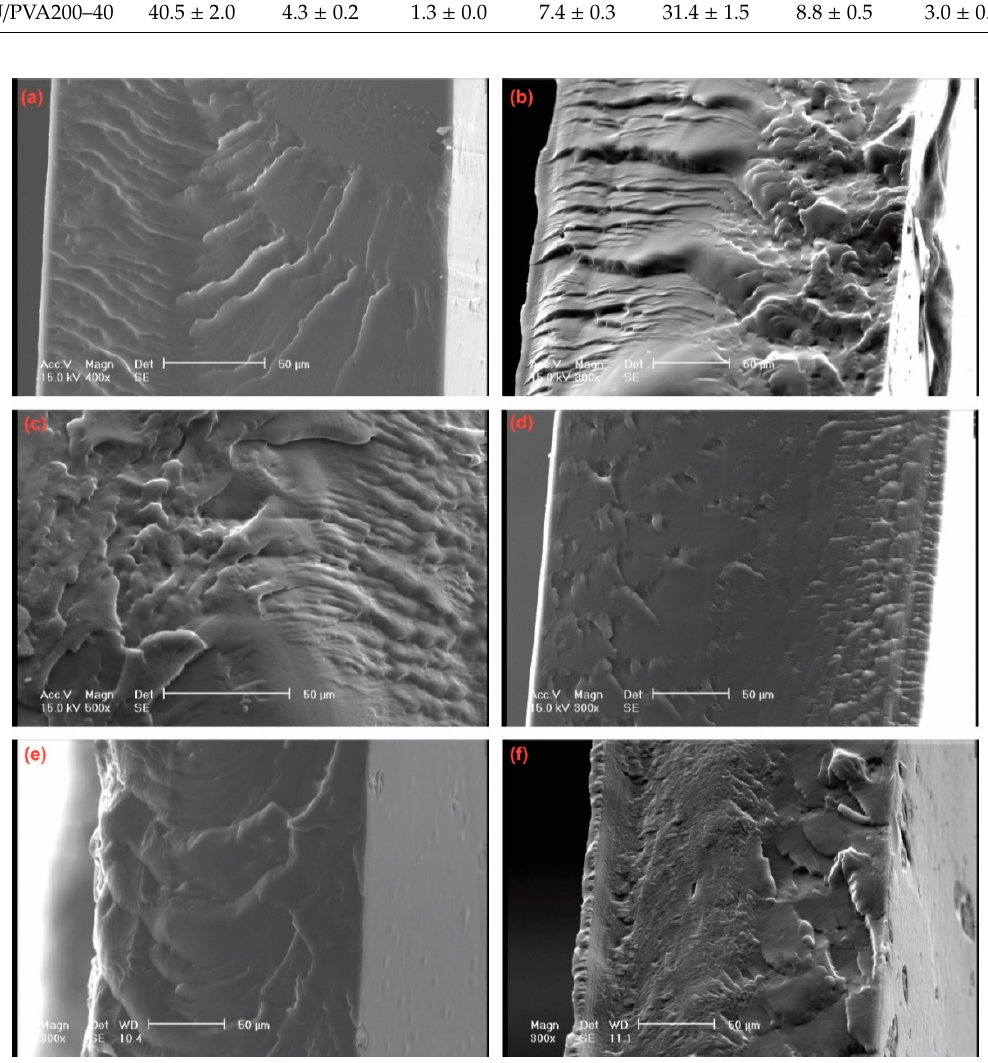
Figure 4. SEM images of ( a ) PU, ( b ) PU/PVA200–5, ( c ) PU/PVA200–10, ( d ) PU/PVA200–20, ( e ) PU/PVA200–30, and ( f ) PU/PVA200–40.